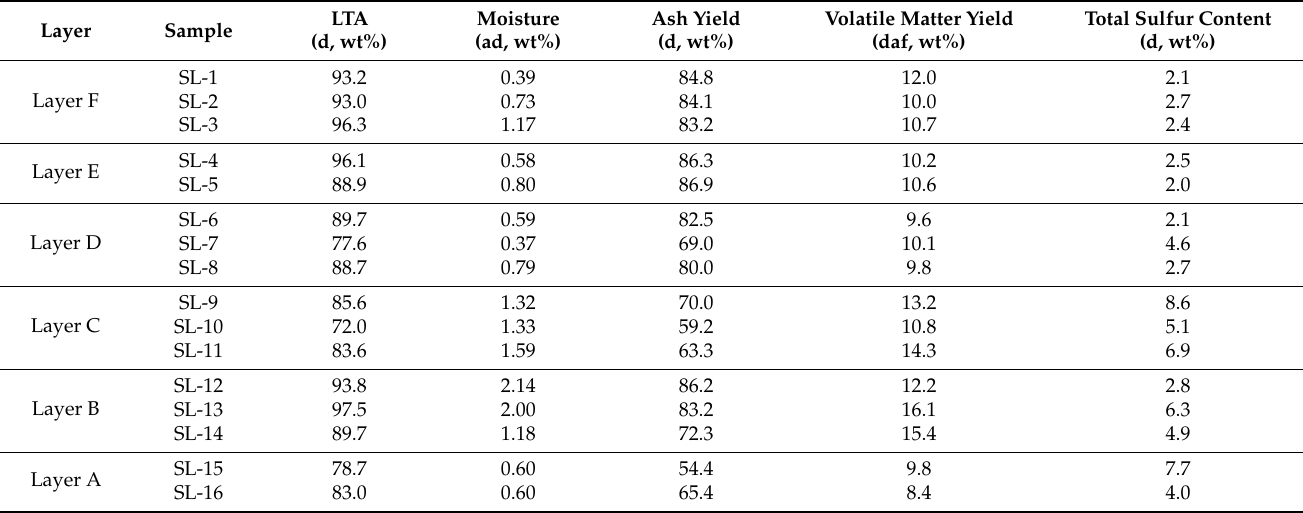
Table 1. Proximate analysis, total sulfur content, and low-temperature ash yield (LTA) of the samples from borehole